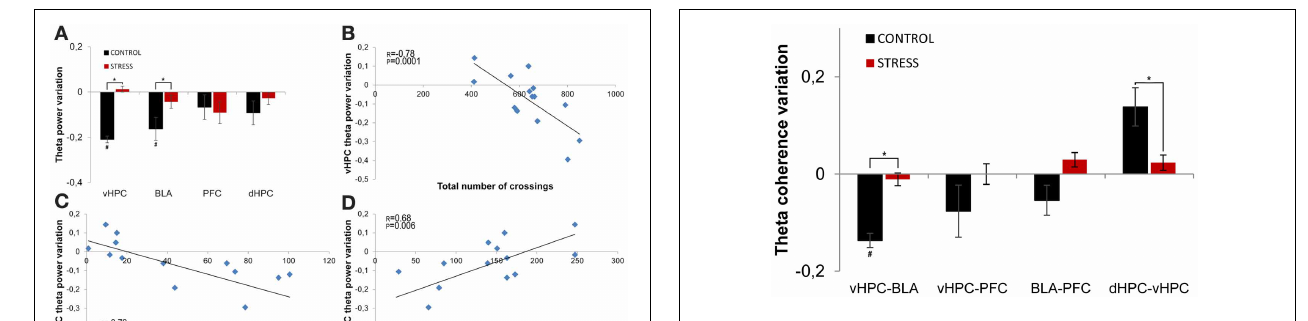
FIGURE 6 | Theta coherence variation between first and last exposures to the OF arena. Theta coherence variation between the first exposure to the OF arena (unfamiliar environment, origin) and the final exposure to the same environment (familiar environment, day 21) for the following brain area pairs: vHPC-BLA, vHPC-PFC, dHPC-vHPC and BLA-PFC. Note that theta coherence variation presented for the novel environment is relative to theta coherence on the first exposure (day 1) to the OF arena. Controls presented a significant decrease of vHPC-BLA theta coherence and a tendency for decrease of vHPC-PFC and BLA-PFC theta coherence between first and last exposures to the OF arena; while stressed rats presented an absence of variation of theta coherence between the same brain area pairs. Control rats also presented increased dHPC-vHPC theta coherence through familiarization between first and last exposures to the OF arena while stress rats failed to display a similar variation. # p < 0 . 05 for paired Wilcoxon sign rank test comparison of within group theta coherence estimates between exposures; ∗ p < 0 . 05 for unpaired Wilcoxon rank sum test comparison of average theta coherence variation between groups on each exposure. Error bars: ± sem. FIGURE 7 | Theta power and coherence variation between final exposure to the OF and novel unfamiliar environment. (A) Theta power variation between last exposure to the OF arena (familiar environment) and the second novel unfamiliar arena from activity recorded from ventral hippocampus (vHPC), basolateral amygdala (BLA), dorsal hippocampus (dHPC), and medial prefrontal cortex (PFC). Note that theta power variation presented for the novel environment is relative to theta power in the last exposure (day 21) to the OF arena. When rats from both groups were exposed to the new unfamiliar arena a significant theta power increase in vHPC and BLA was observed in controls but not on stressed rats. No significant variations were observed in dHPC and PFC theta power between plotted exposures or between groups on each exposure. (B) Theta coherence variation between the last exposure to the OF arena (familiar environment, day 21) and the second novel unfamiliar arena (day 24) for the following brain area pairs vHPC-BLA, vHPC-PFC, dHPC-vHPC, and BLA-PFC. When all rats were moved to the new unfamiliar environment control rats presented a significant increase of BLA-PFC theta coherence only; while stressed rats presented a significant increase of vHPC-BLA theta coherence. On dHPC-vHPC theta coherence, control rats presented a decrease whereas stressed rats showed no variation. # p < 0 . 05 for paired Wilcoxon sign rank test comparison of within group theta power and theta coherence estimates between exposures; ∗ p < 0 . 05 for unpaired Wilcoxon rank sum test comparison of average theta power and theta coherence variation between groups on each exposure. Error bars: ±